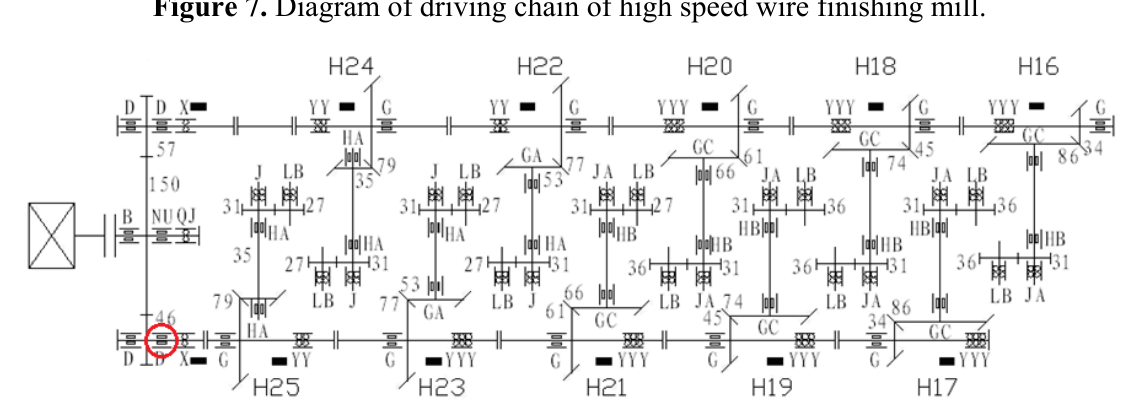
Figure 7. Diagram of driving chain of high speed wire finishing